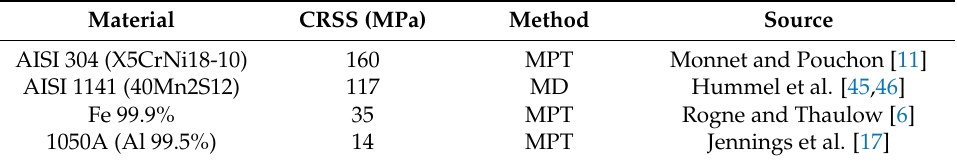
Table 2. CRSS (critical resolved shear stress) values for different materials.